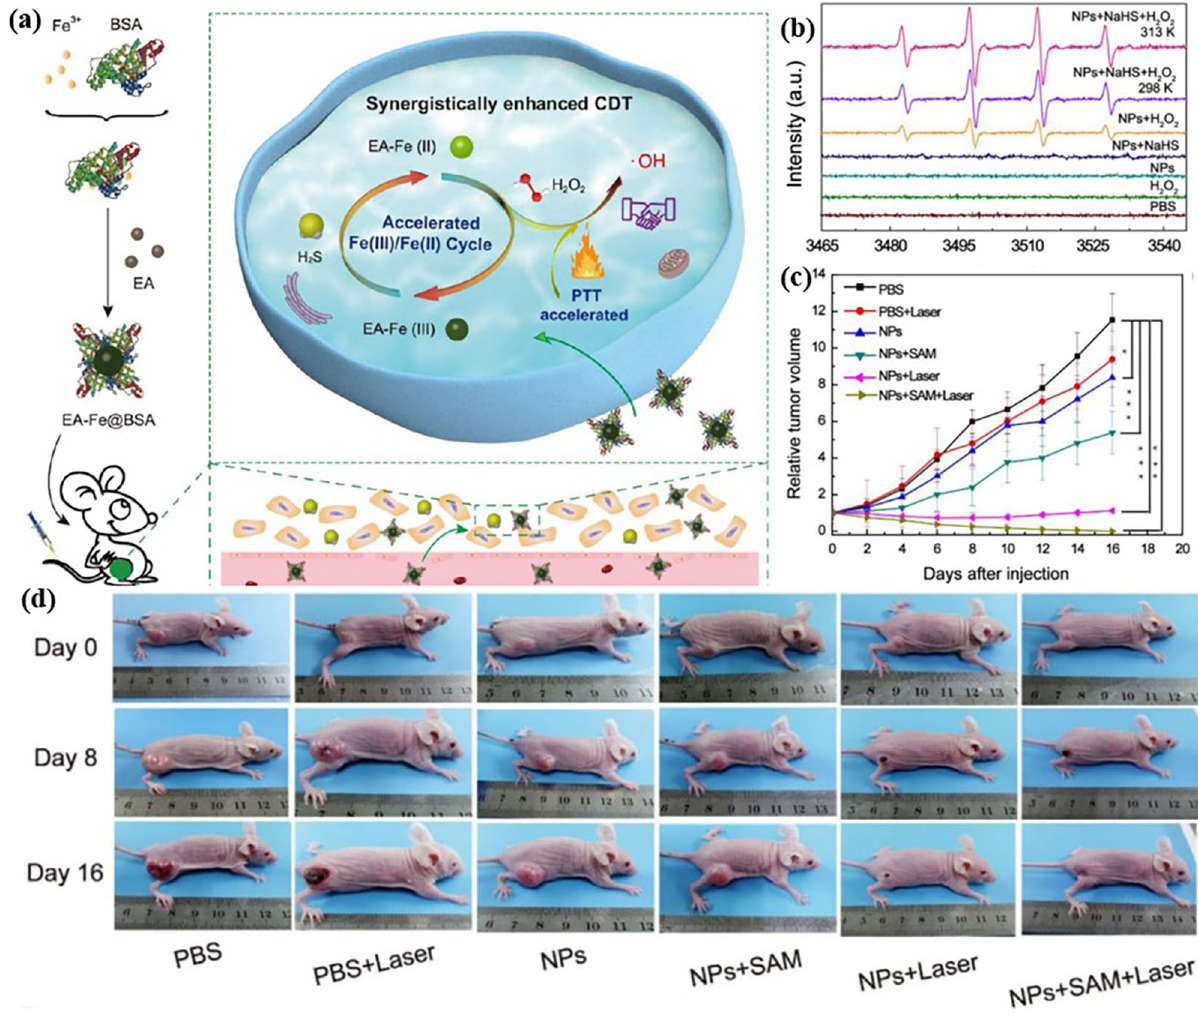
Figure 10: ( a ) An illustration of the synthesis of the EA - Fe@BSA NPs and H 2 S - triggered Fe ( III ) /Fe ( II ) conversion and PTT synergistically enhanced CDT. ( b ) ESR spectra for · OH detection. ( c ) Relative tumor volume. ( d ) Photographs of mice on days 0, 8, and 16 of treatments. Reprinted with permission from Ref. [ 113 ] ; Copyright © 2020 IVY